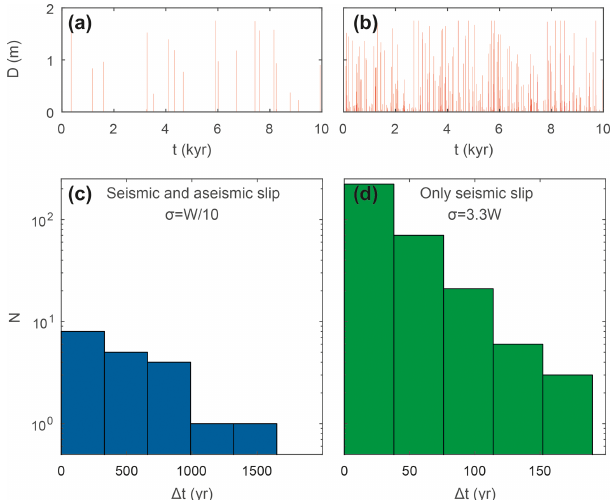
Figure 5. Time distribution of earthquakes rupturing the river. (a– b) Co-seismic displacements D at the location of the river as a func- tion of time t for each model. (c–d) Distribution of inter-event time (cid:49)t of earthquakes rupturing the surface at the location of the